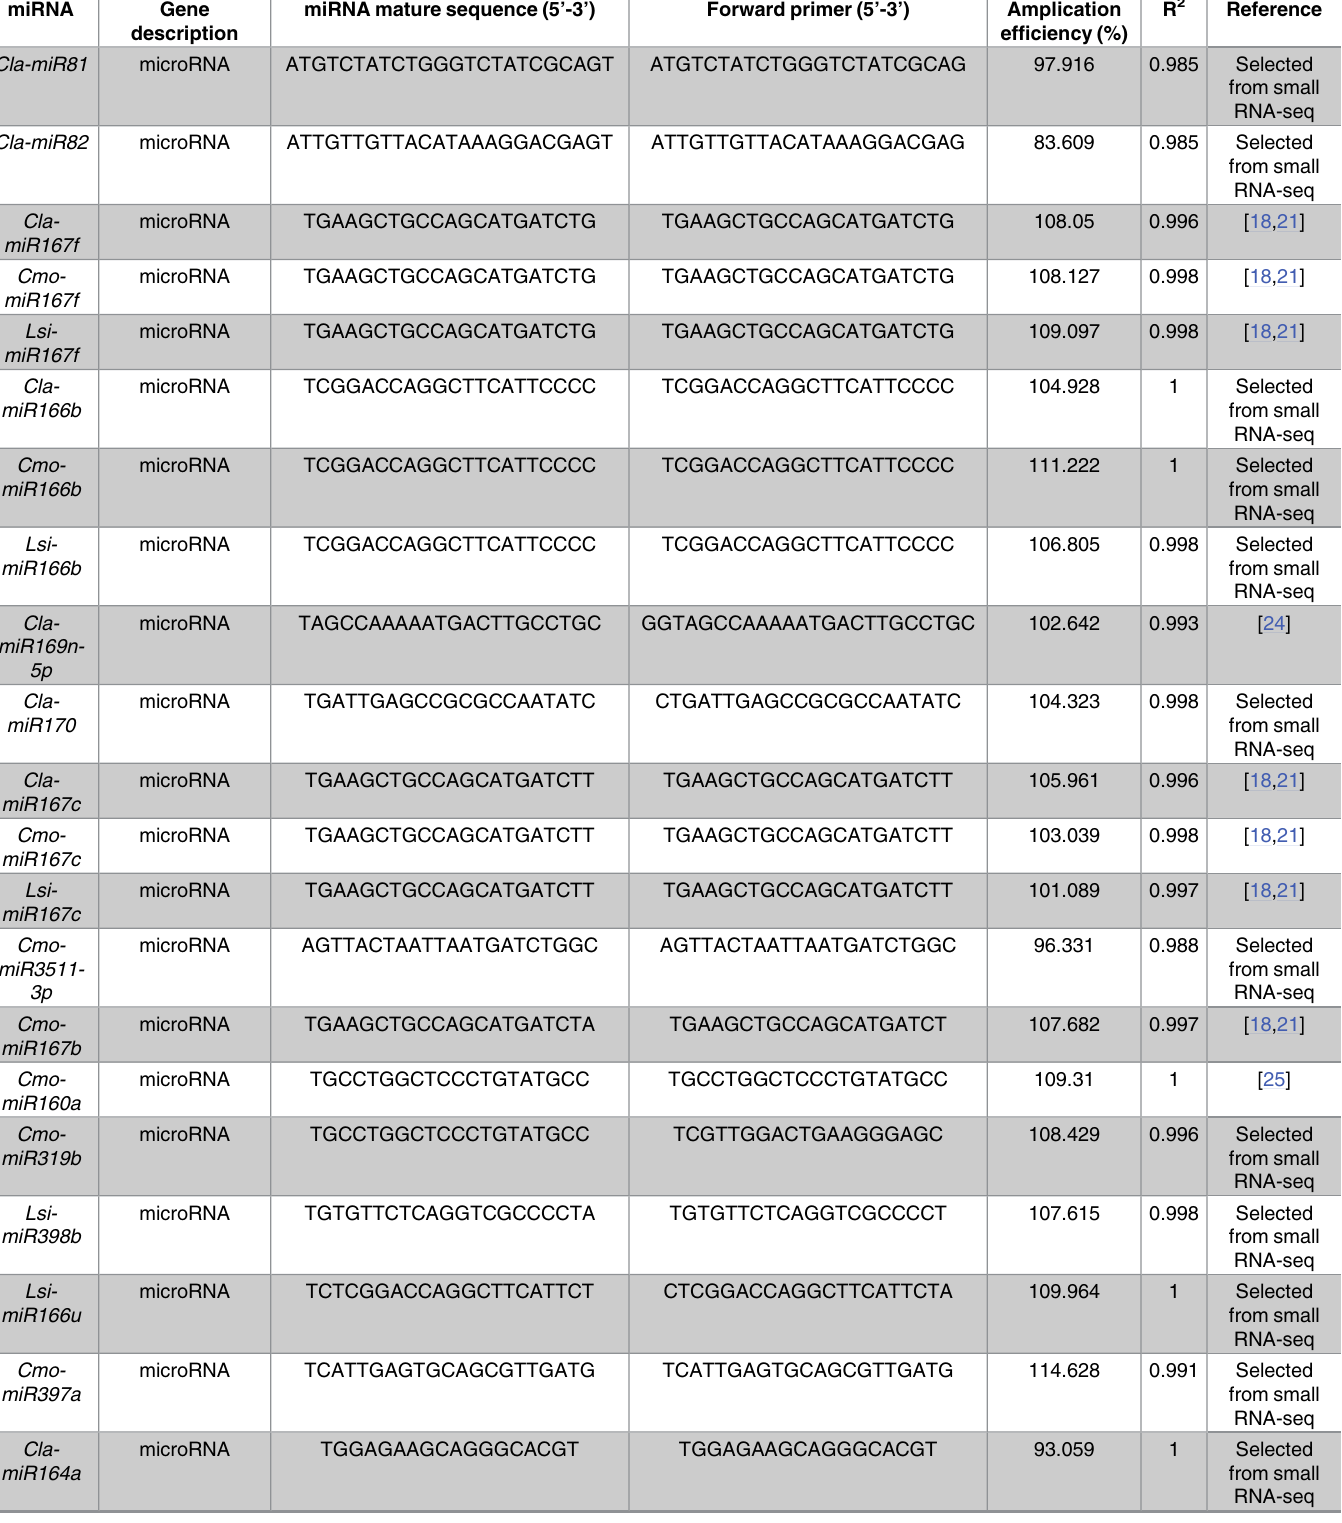
Table 1. Sequence information of the templates and primers for qRT-PCR.